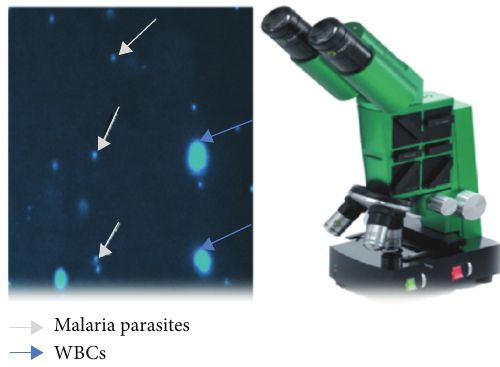
Figure 1: Partec CyScope fluorescence microscope and malaria parasites (adapted from